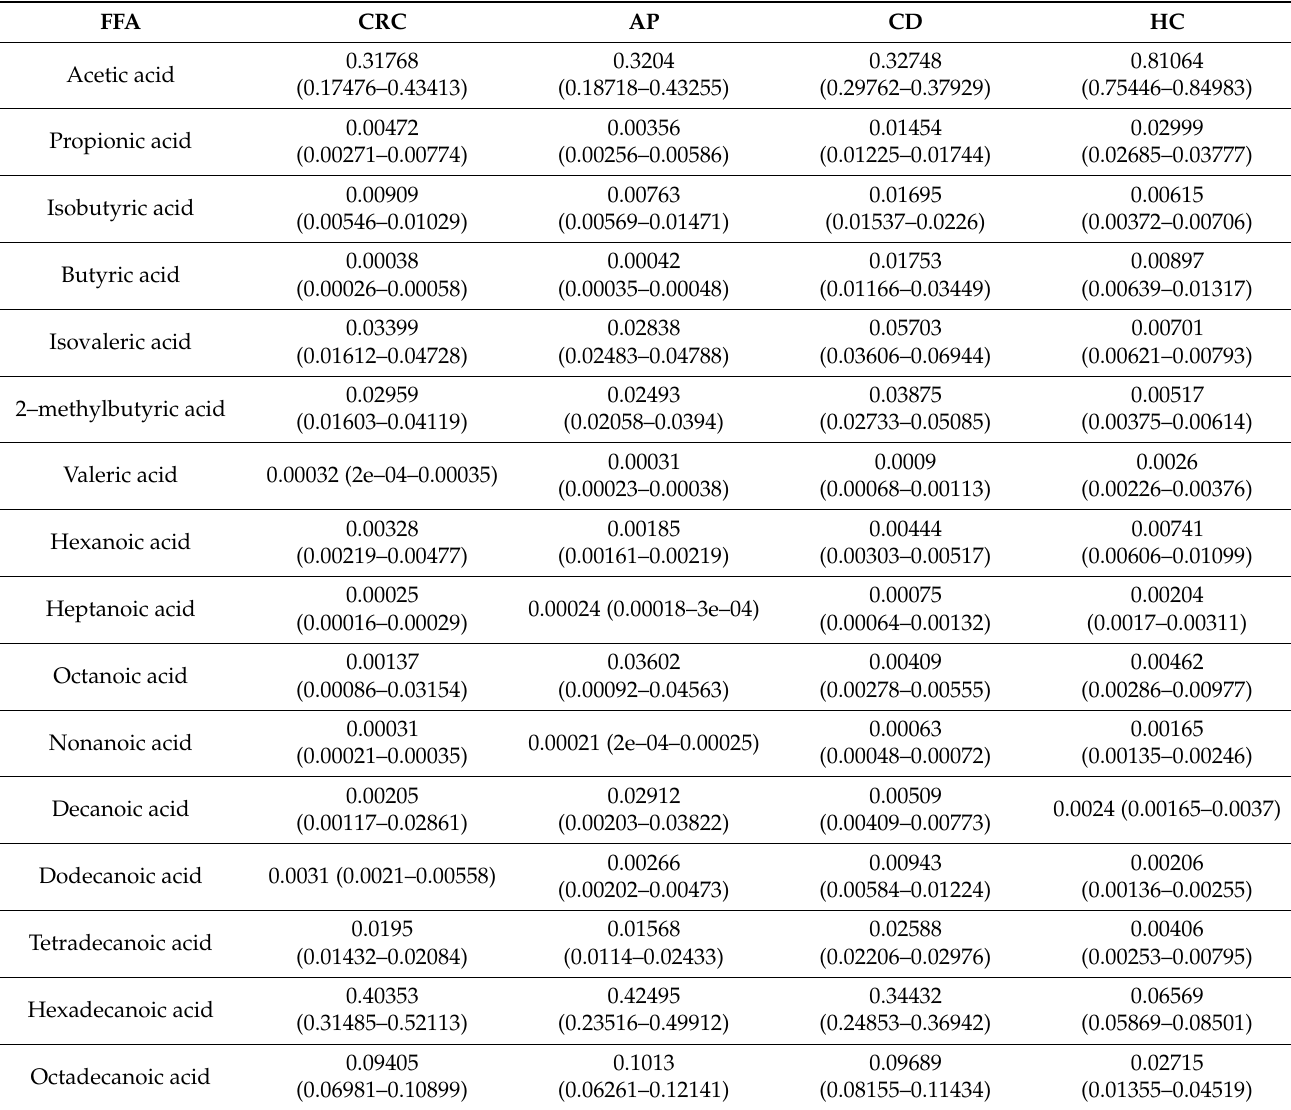
Table 2. Representation of the median (Q1–Q3) of each FFA percentage in CD, CRC, AP patients and healthy controls. FFA = free fatty acid; HC = healthy controls; CD = celiac disease; AP = adenomatous polyposis; CRC = colorectal